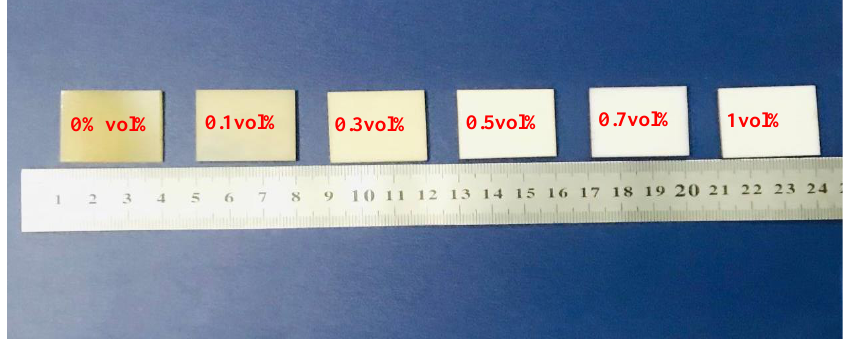
Figure 1: The prepared samples of ZnO/ sawdust /epoxy nanocomposite with different ZnO